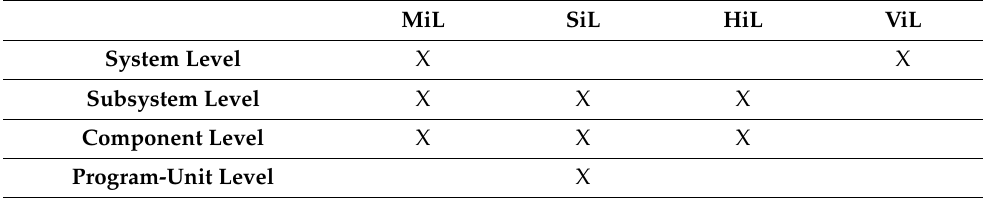
Table 1. Levels of system view and the type of SuT integration that is possible at each of these. MiL SiL HiL